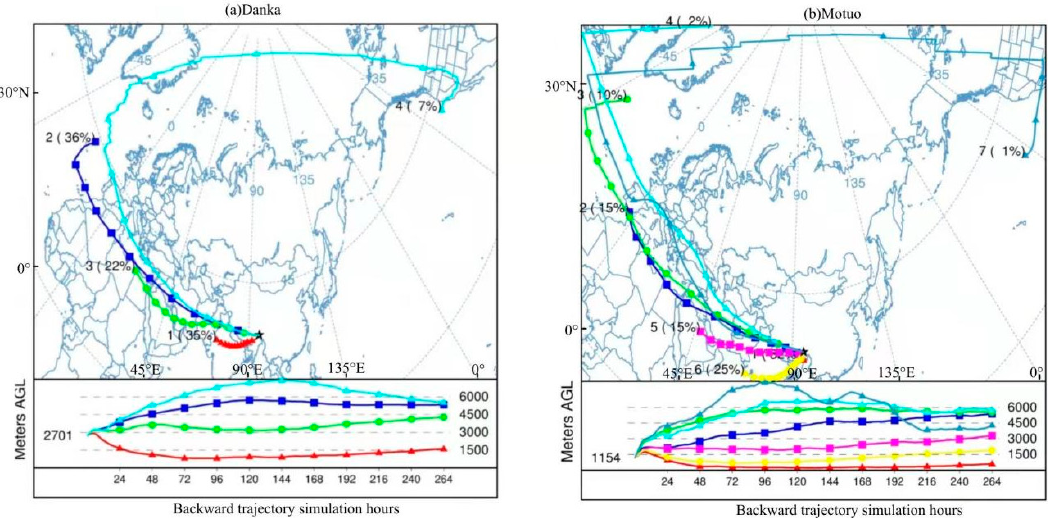
Figure 2. Eleven-day backward water vapor transport trajectories for Danka station and Motuo station during the non-AMS.